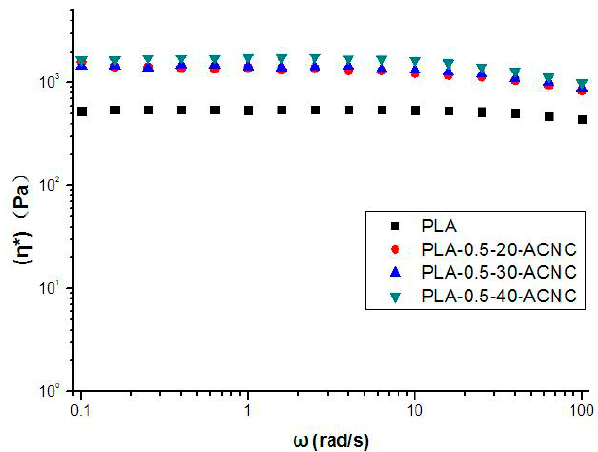
Figure 7. Complex viscosity ( η *) of PLA/ACNC composite films as a function of frequency.